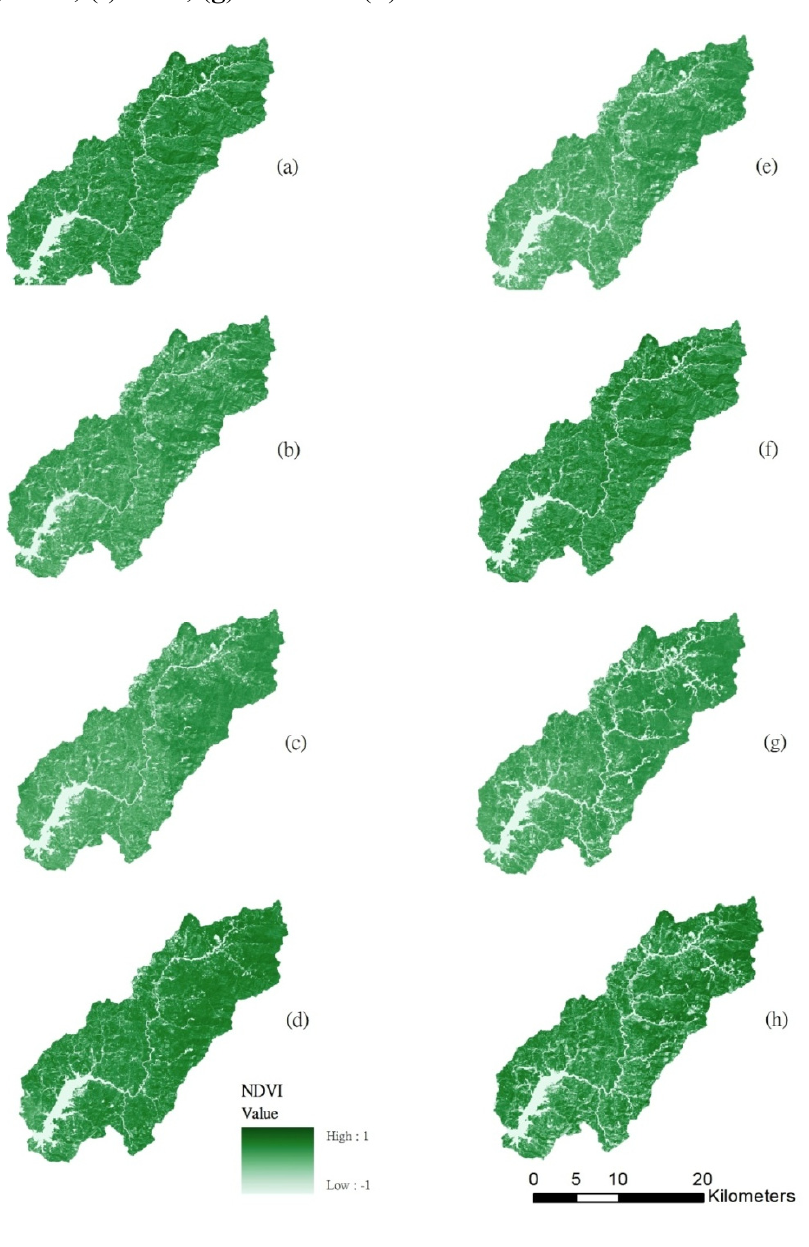
Figure 4. Images of NDVI patterns in the study area during ( a ) 2001, ( b ) 2003, ( c ) 2004, ( d ) 2005, ( e ) 2007, ( f ) 2008, ( g ) 2009 and ( h ) 2010.